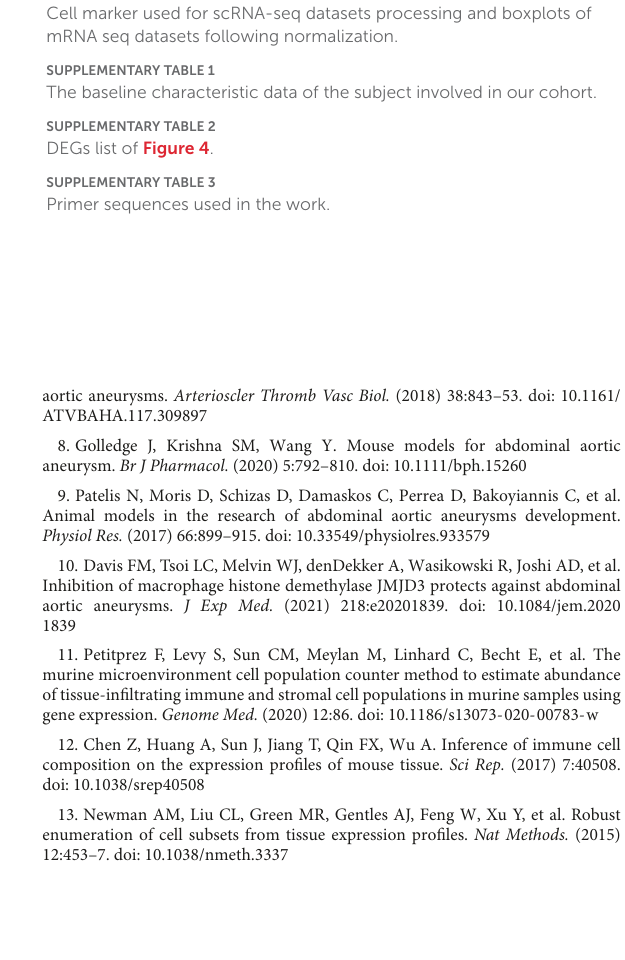
SUPPLEMENTARYFIGURE1 Cell marker used for scRNA-seq datasets processing and boxplots of mRNA seq datasets following normalization. SUPPLEMENTARYTABLE1 The baseline characteristic data of the subject involved in our